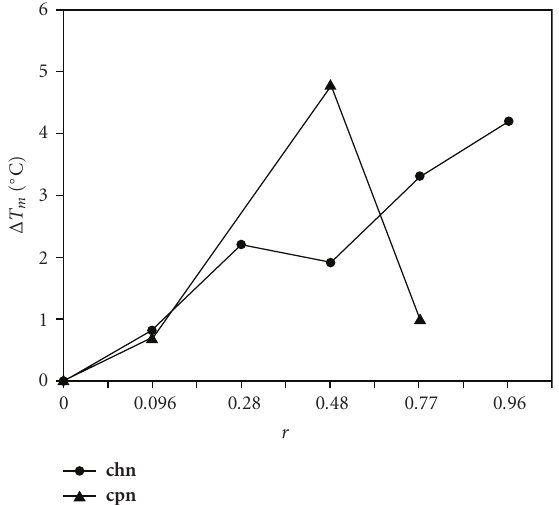
Figure 7: Calf thymus DNA Δ Tm values at increasing amounts of [Cu(hsm)(nal)H 2 O]Cl · 3H 2 O and [Cu(phen)(nal)H 2 O]NO 3 · 3H 2 O